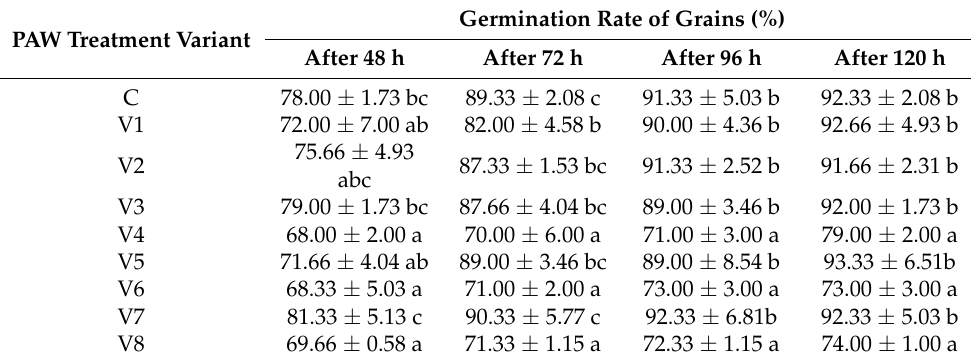
Table 4. Germination dynamics of wheat grains represented by the germination rate (%) after non-thermal plasma-activated water treatments.